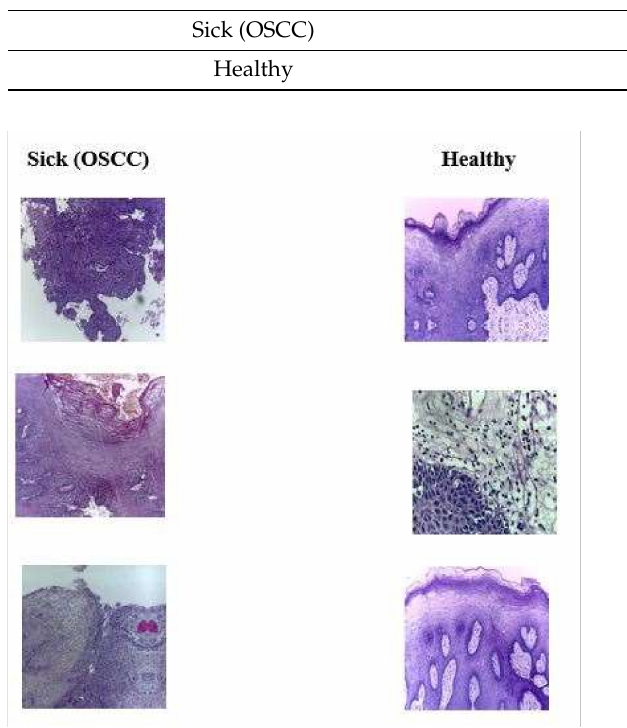
Figure 2. Sick and healthy oral squamous cell carcinoma biopsy dataset.